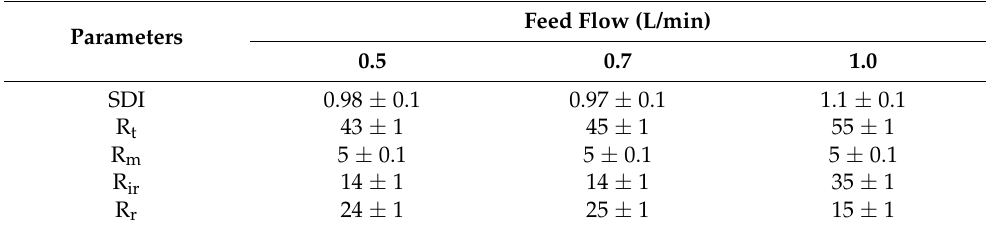
Table 4. Data of SDI and resistances of flux permeation (nm − 1 ) from RO membrane during effluent